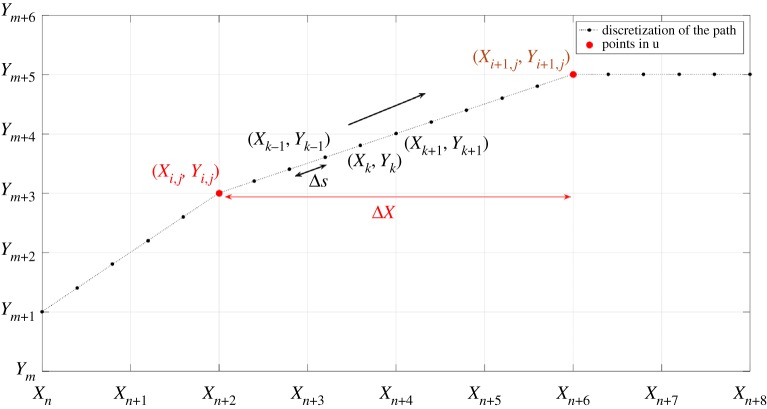
Discretization of the trajectory of the centre of the beam.